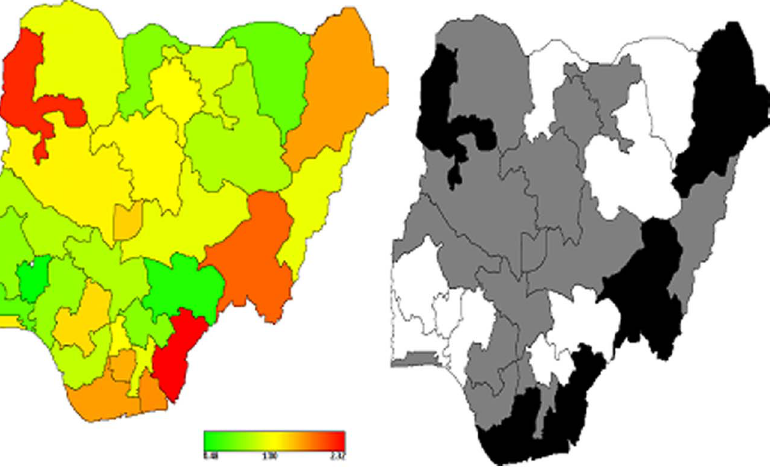
Figure 3. Total residual spatial effects, at state level in Nigeria, of obesity/overweight. Shown are the posterior odds ratios (left) and corresponding posterior probabilities at 80% nominal level